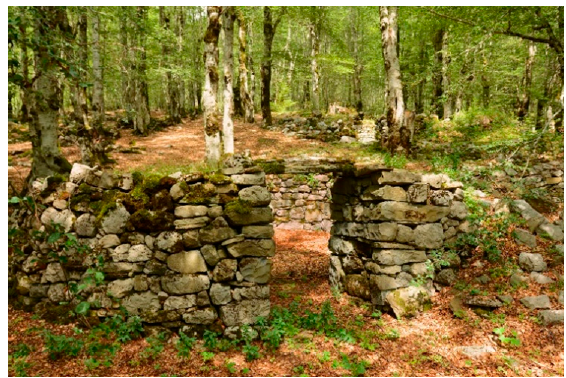
Figure 11. An entrance into dubirog - katun Crna rupa, photo: I. Lakovi ć .